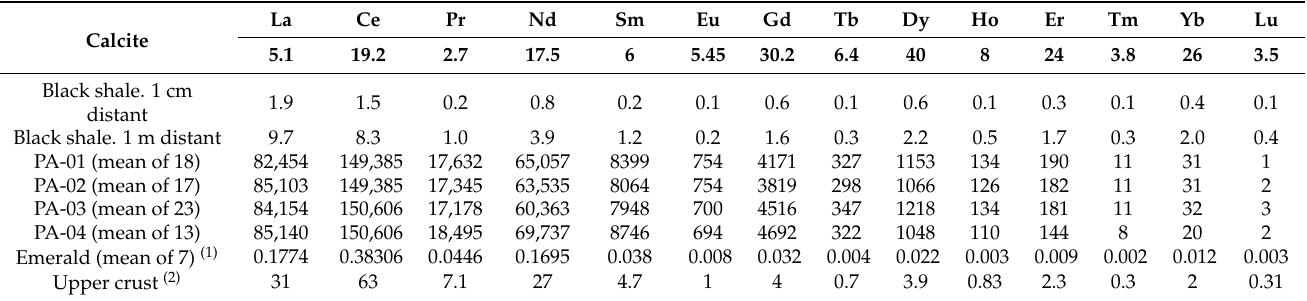
Table 3. REE concentrations of the wall rock, emeralds and calcite. ICP-OES technique was used for calcite and wall rock analyses. Parisites and emeralds were analyzed by ICP-MS. (1) Emerald values are the mean of seven samples of Alonso-Perez et al. (2021). (2) Upper crustal values are from Rudnik et al. (2003). All concentrations in